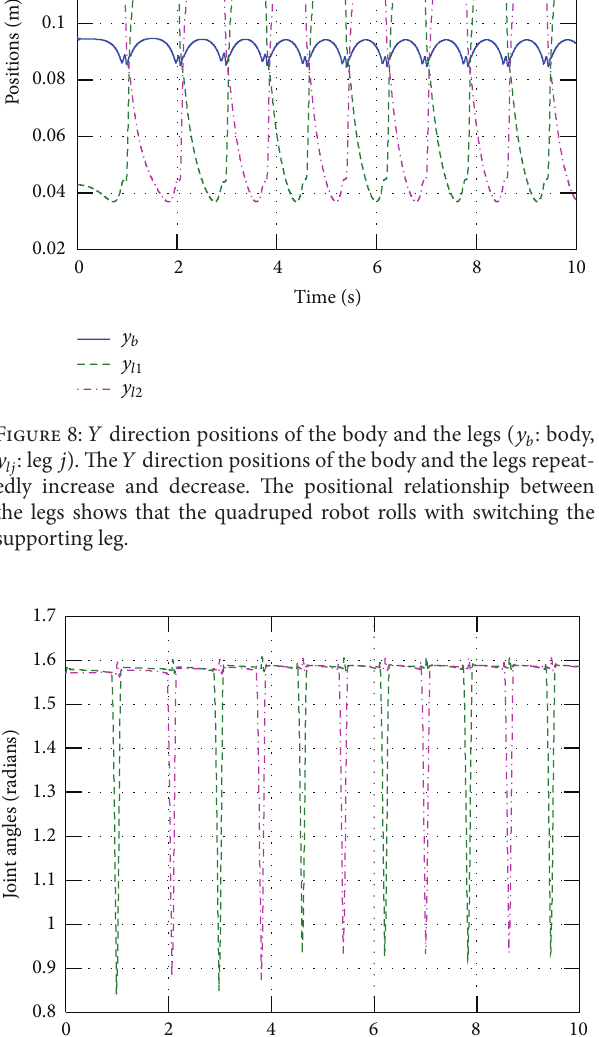
Figure 7: 𝑋 direction positions of the body and the legs ( 𝑥 𝑏 : body, 𝑗 ). The 𝑋 direction positions of the body and the legs increase 𝑥 𝑙𝑗 : leg over time. It means that the quadruped robot moves in the positive direction, and the robot moves 2.91 m in 10s.